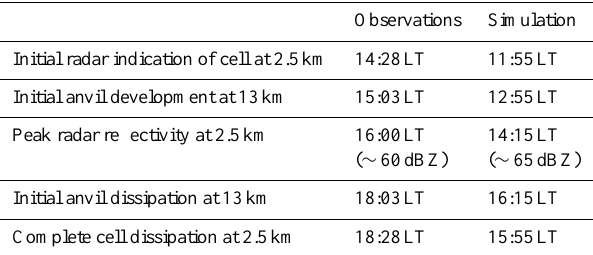
Table 2. Summary of the observed and simulated features in the 16 November 2005 Hector thunderstorm. Observations